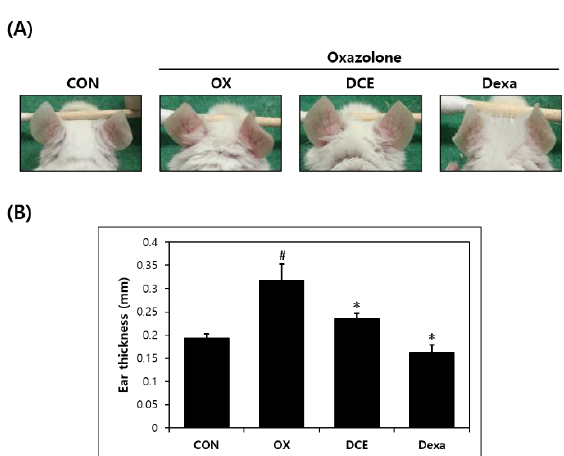
Figure 1. Effect D. costaricensis EtOH extract (DCE) on OX-induced AD-like lesions in the BALB/c mouse model. ( A ) Clinical features of AD-like symptoms. ( B ) Ear thickness. CON group: vehicle controls, OX group: oxazolone-treated controls, DCE group: oxazolone plus 1% DCE-treated, and Dexa group: oxazolone plus 0.1% dexamethasone-treated. Data values are presented as means ± SEMs. # p < 0.05 vs. the CON group, * p < 0.05 vs. the OX group.